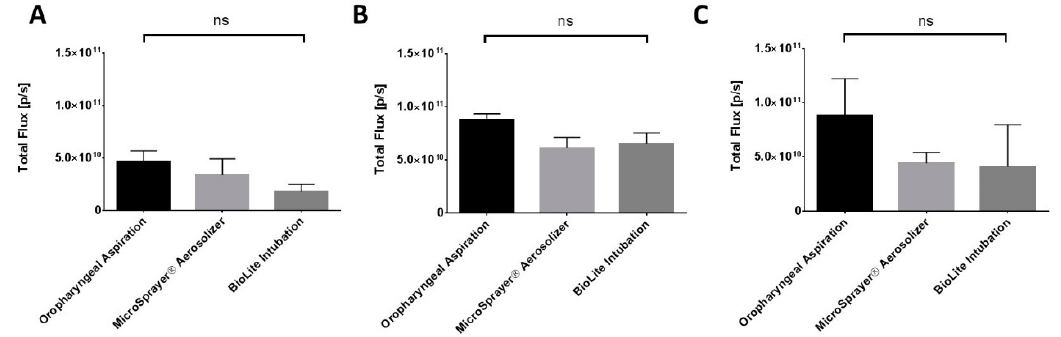
Figure 8. Total flux ( ρ /s) of fluorescence in excised lungs of mice at ( A ) 1 h, ( B ) 4 h, and ( C ) 24 h after administration of near-infrared fluorescent Degradex ® poly( D , L -lactide-co-glycolide) (PLGA) microspheres using oropharyngeal aspiration, the MicroSprayer ® Aerosolizer, and the BioLite Intubation System ( n = 3–4, mean ± SEM, one-way ANOVA, Tukey’s multiple comparison test).